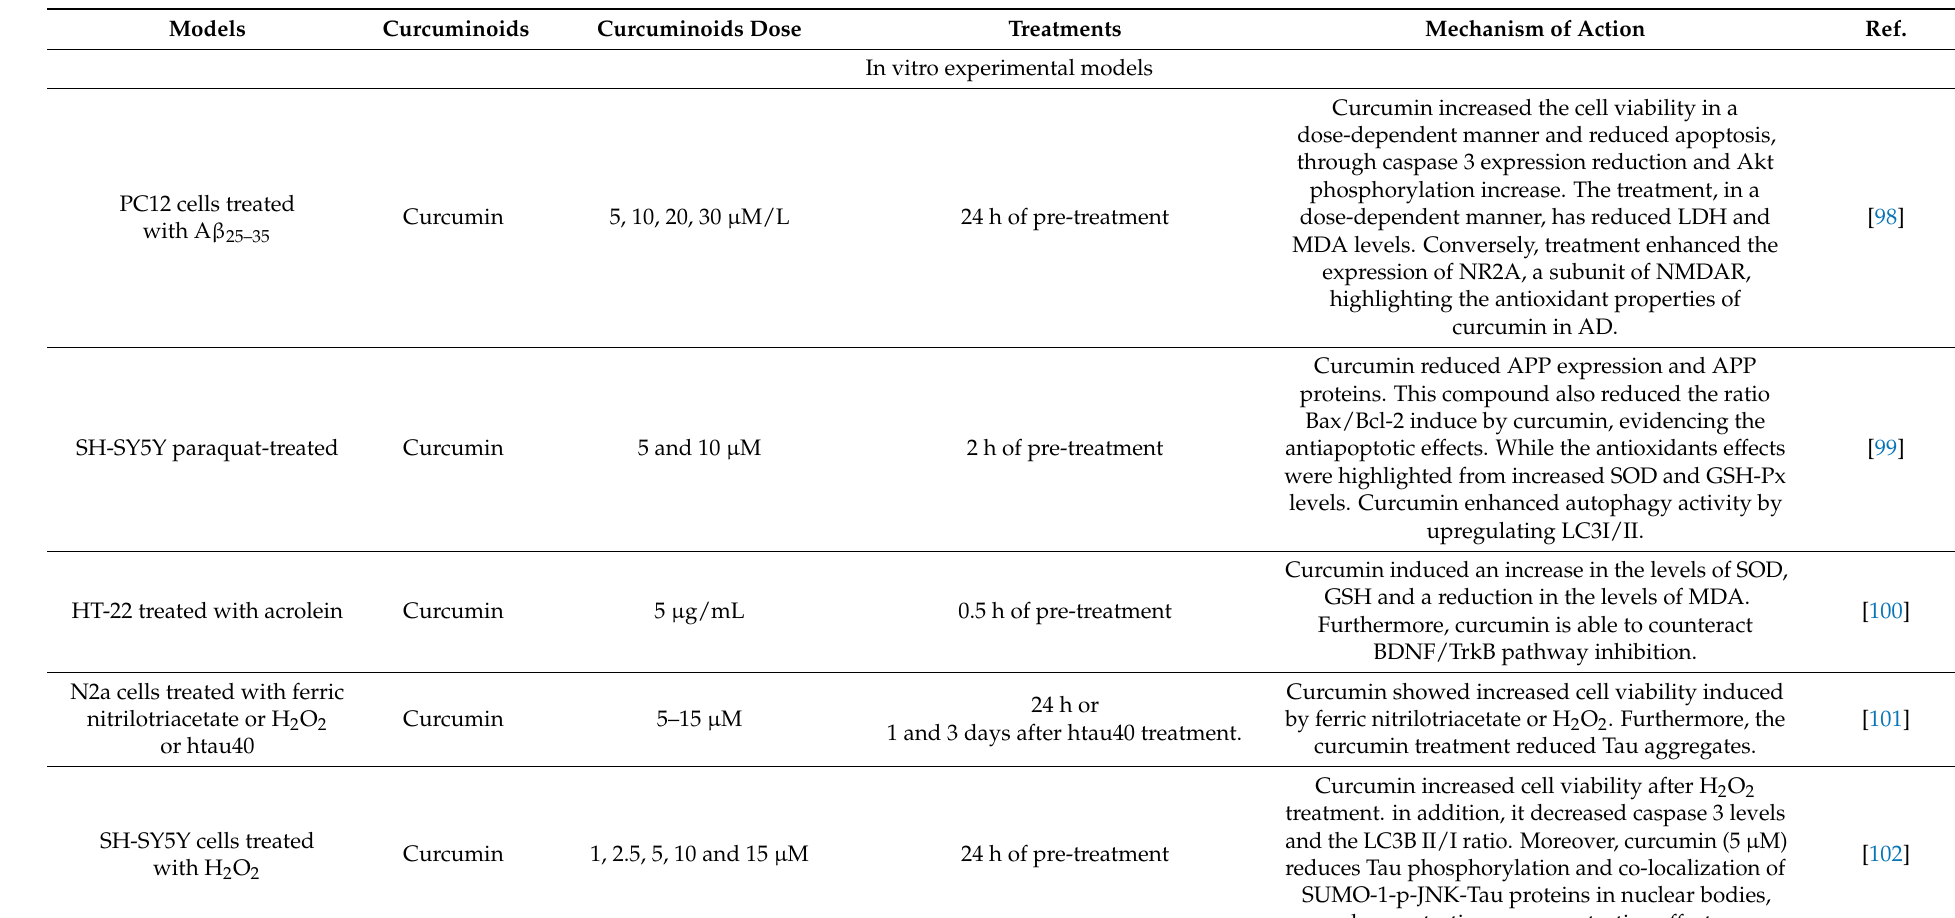
Table 2. Antioxidant effects of curcuminoids in